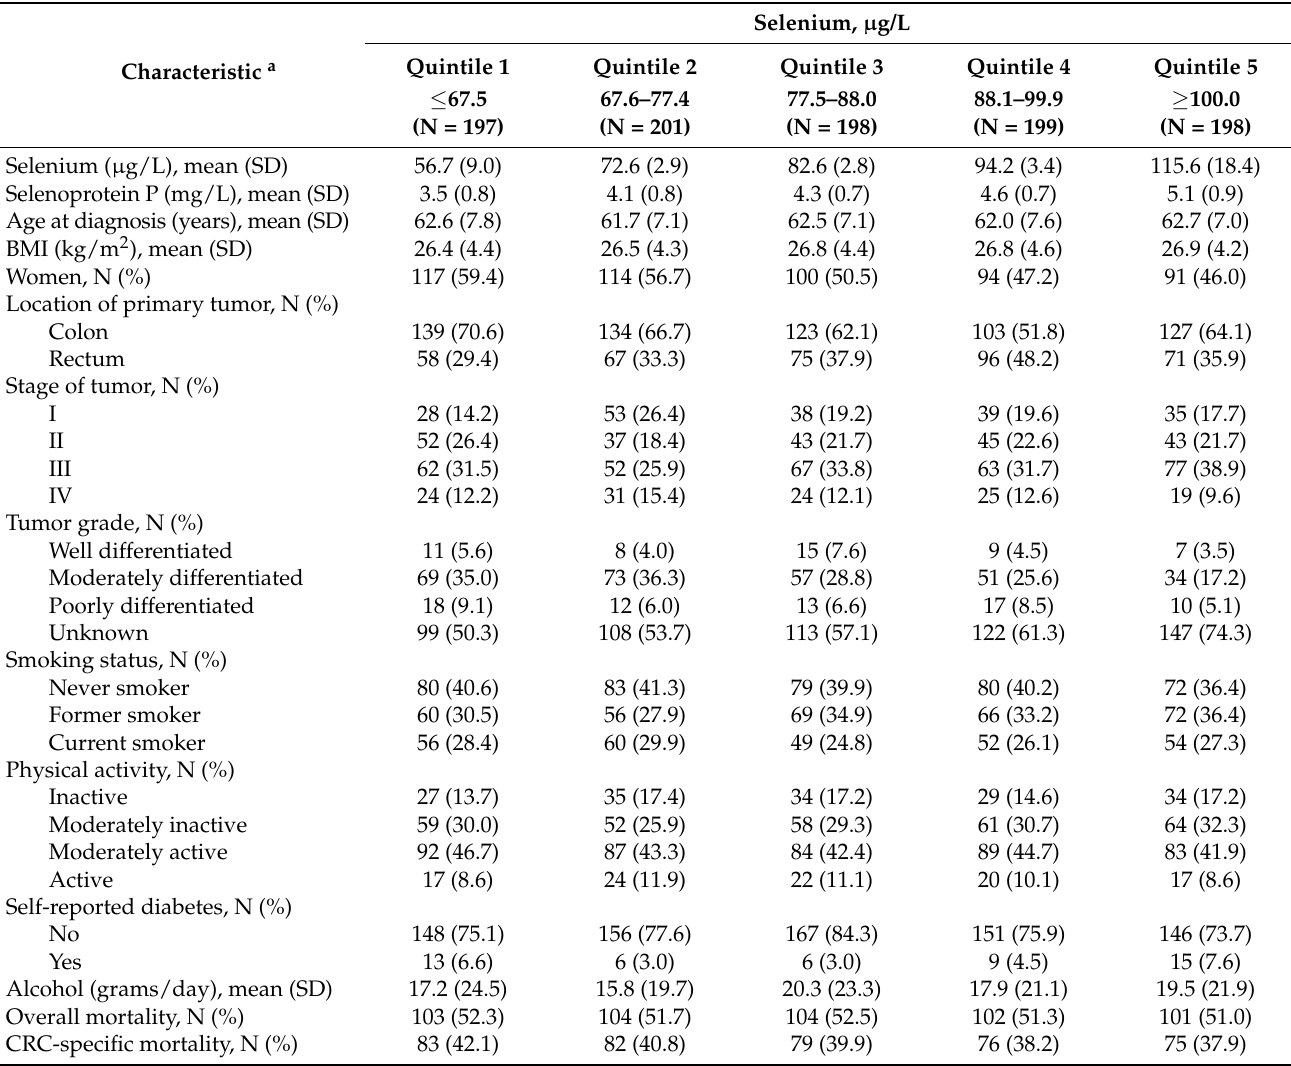
Table 1. Selected baseline characteristics of CRC cases according to quintile of prediagnostic serum Se in the EPIC